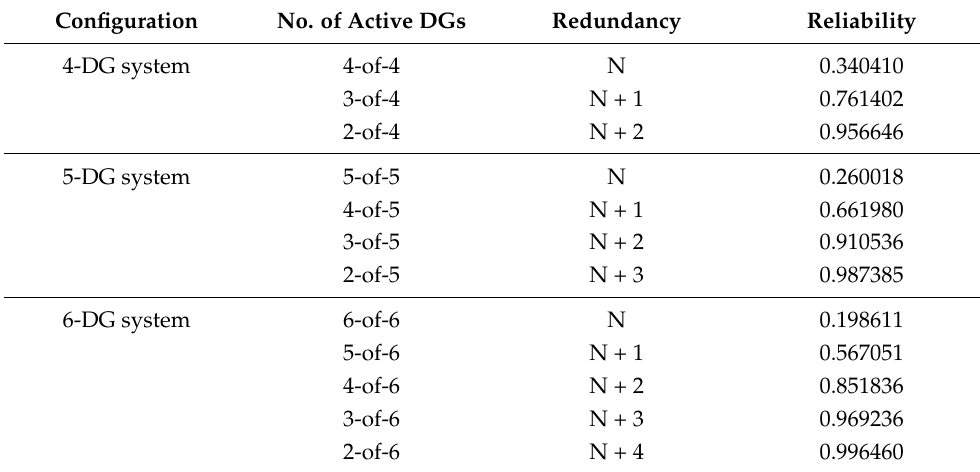
Table 4. Reliability for N + X redundancy